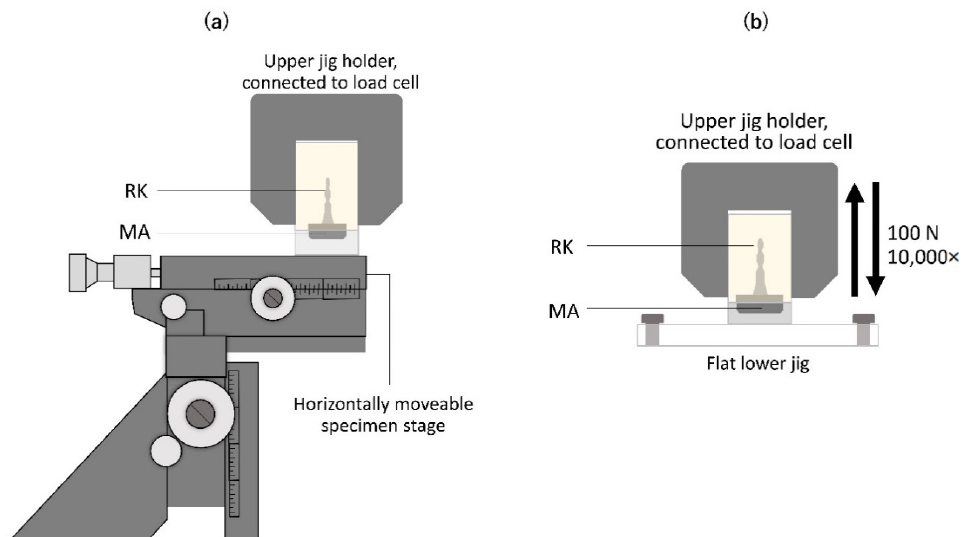
Figure 3. Experimental settings on the universal testing machine to evaluate the retentive force at displaced positions ( a ) and to perform the load test ( b ).